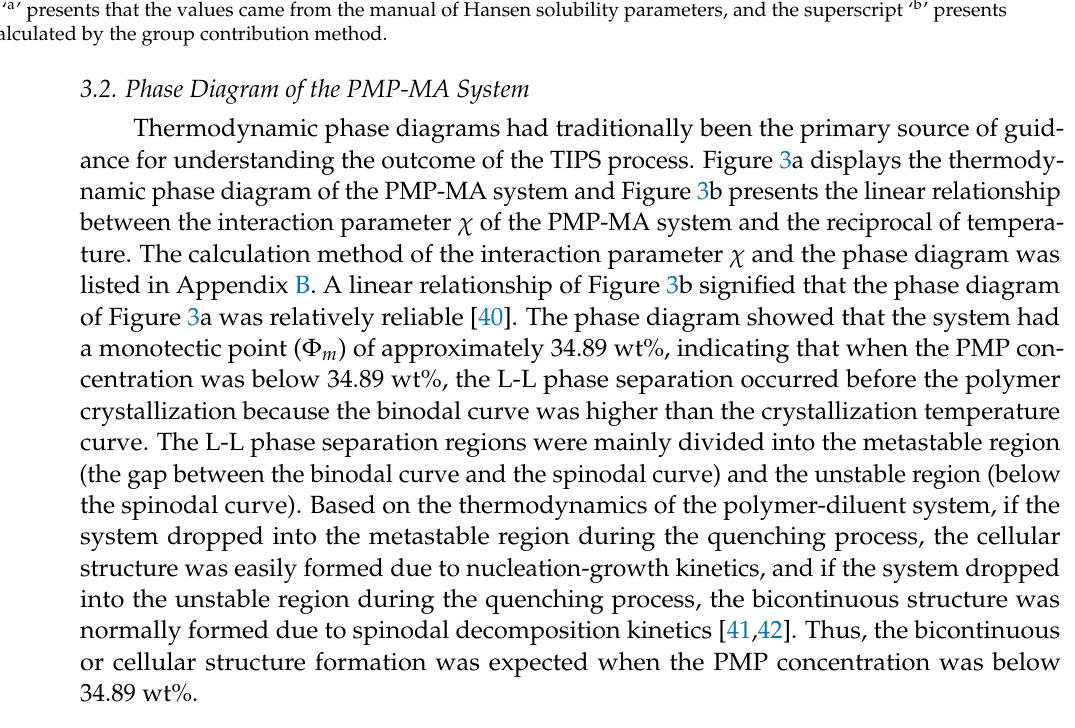
Table 3. The Hansen solubility parameters and the membrane structures of the different PMP-diluents systems. Polymer or Diluent